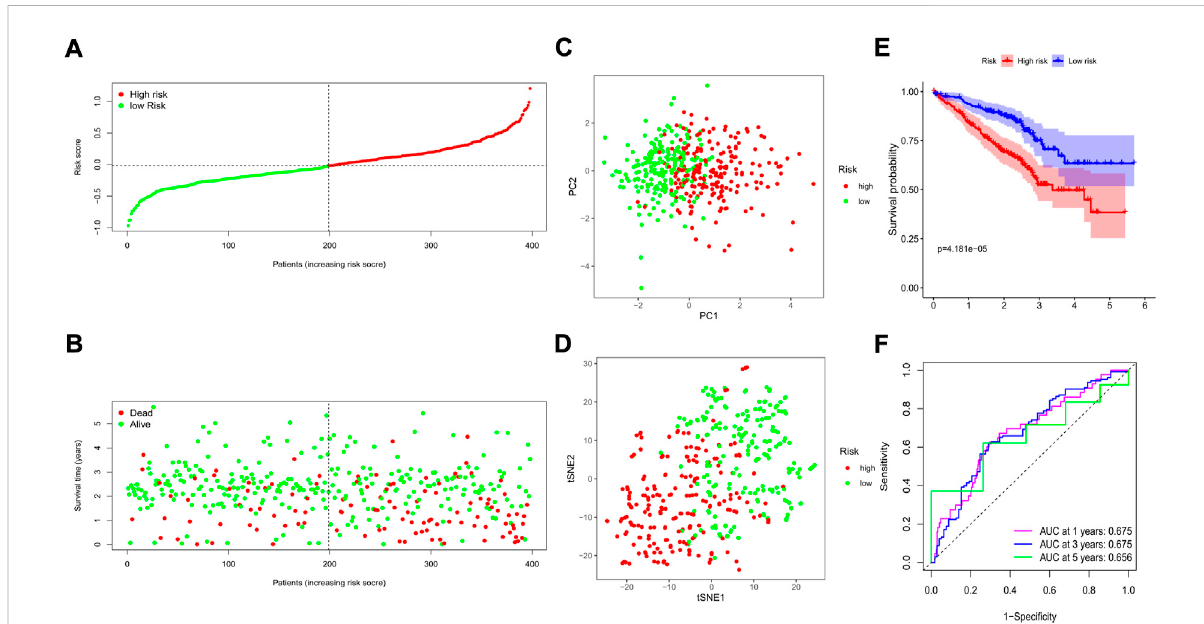
FIGURE 6 Validation of the prognostic value of the risk signature in an external GEO cohort. (A) The distribution of risk scores for each patient; (B) Survival status for each individual (low-risk: left of the dotted line; high-risk: right of the dotted line); (C) The PCA plot for the two risk groups; (D) The t-SNE analysis for the two risk groups; (E) The Kaplan – Meier curves to compare the OS time between the two risk groups; (F) The time-dependent ROC curves for 1-, 3-, and 5-years.